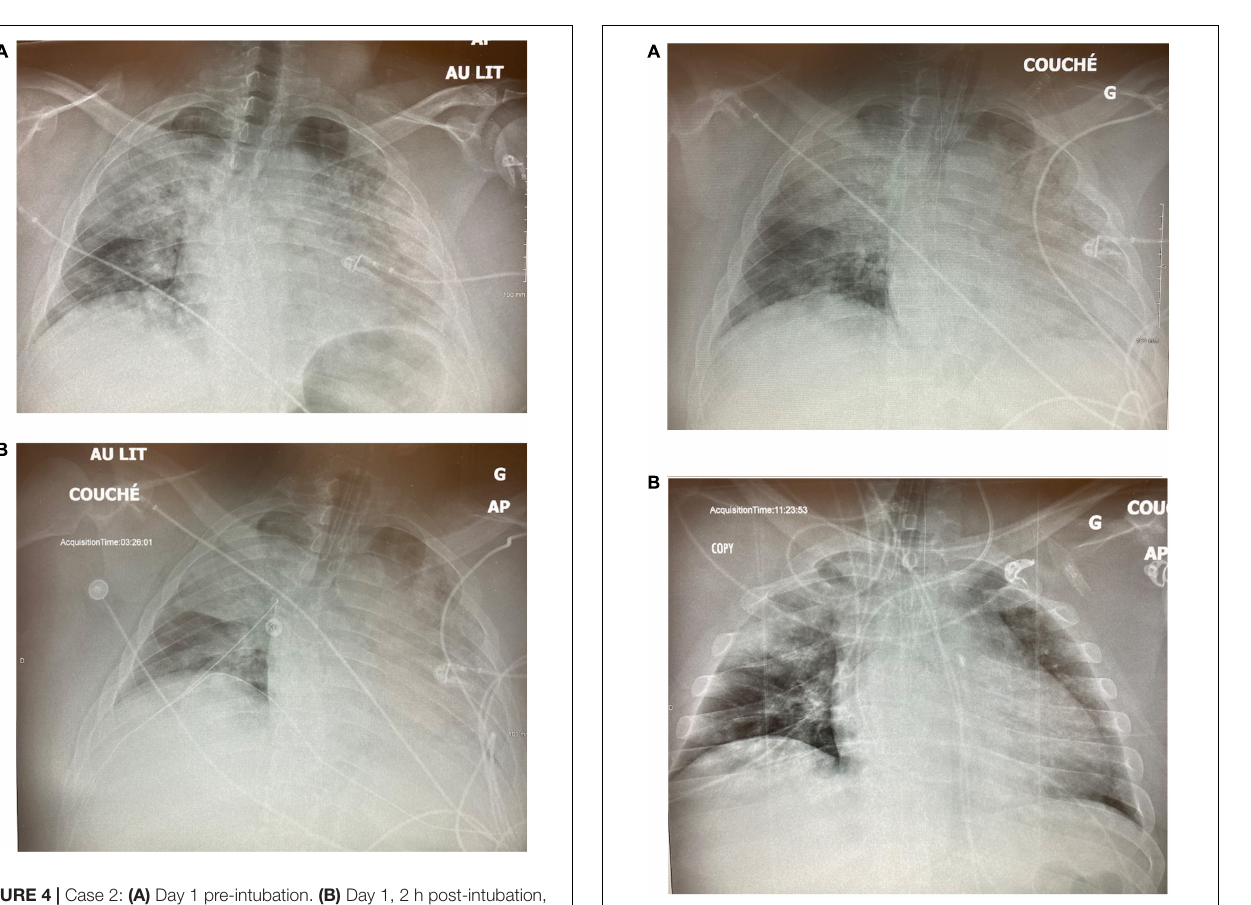
FIGURE 4 | Case 2: (A) Day 1 pre-intubation. (B) Day 1, 2 h post-intubation, on CMV.